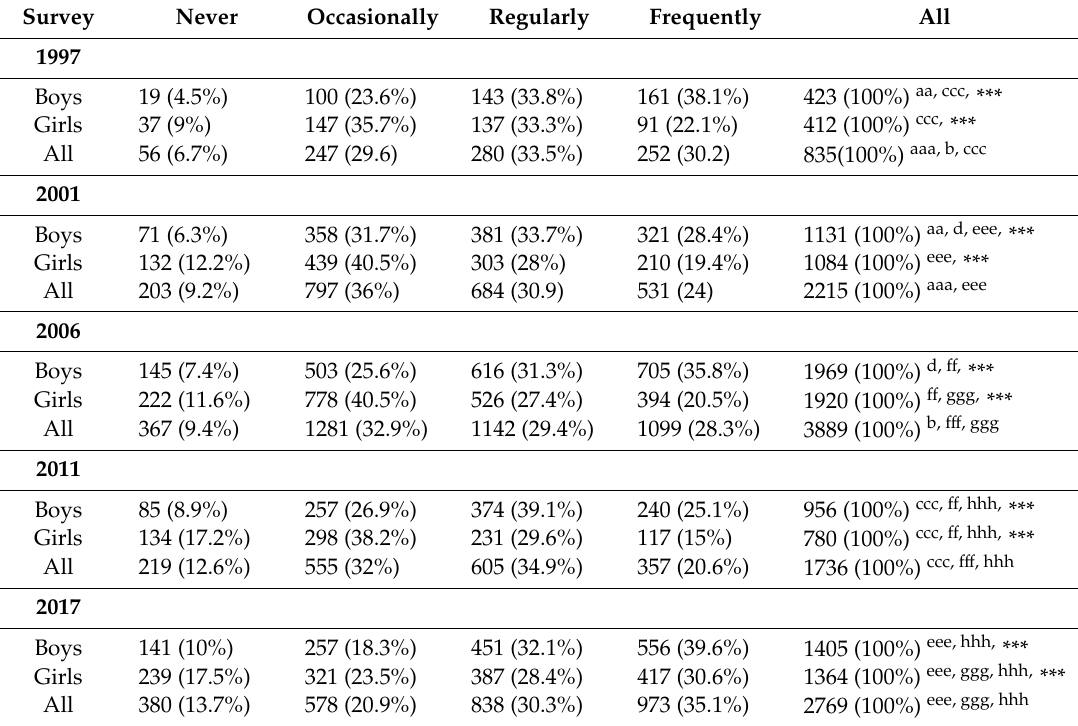
Table 2. Frequency of physical activity practice [data provided: n